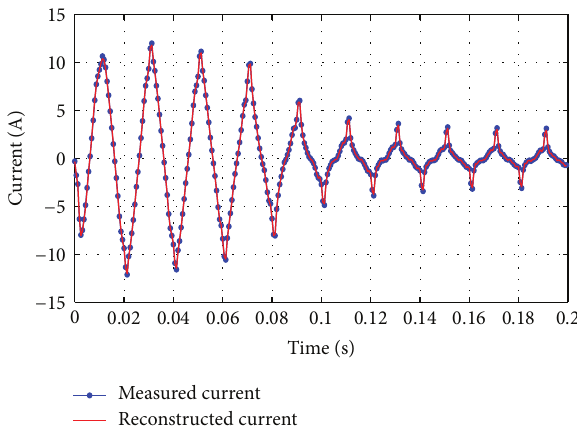
Figure6:Themeasuredandreconstructedcurrentsofthetelevision set.